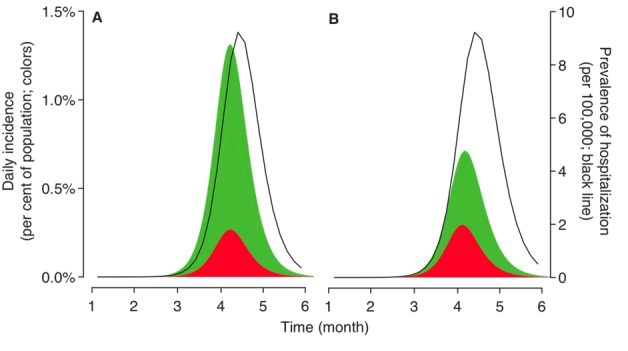
Epidemic curves based on surveillance data could mask quite different underlying transmission dynamics. We used deterministic SIR model [25] with two age classes: children (20% of the population) and adults (80%). The initial doubling time was set to 5 days with a 2.6 day generation time. These parameters imply a basic reproductive number of 1.4 (for this model [5]). The seed was equivalent to one infectious individual in a population of 7 million at time 0 and mixing between age groups was consistent with contact diary data for the UK [26] (children defined as <20 years). The shaded regions show daily incidence of symptomatic cases for children (red) and adults (green). We assumed 86% of infections were symptomatic [8] . The black line is the estimated number of hospital beds required at a given time. The susceptibility of children relative to adults was parameterized using the ratio of child cases to adult cases during the exponential phase of epidemic growth. A shows a baseline scenario. The ratio of early cases was proportionate to the population (20:80, children:adults) and all ages were equally likely to require hospitalization. B shows a scenario likely to be closer to current nH1N1 dynamics. The ratio of early cases was 50:50 and adults were much more likely to require hospitalization.